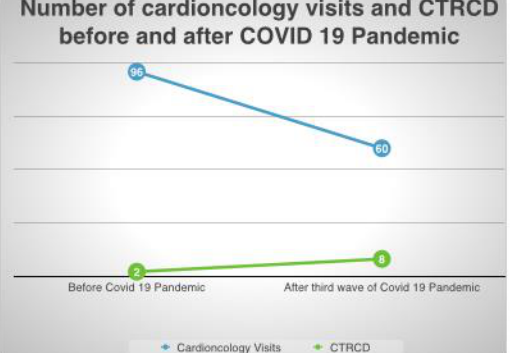
Figure 2. Graphical rapresentation of CTRCD and Cardio-Oncology visits before and after COVID-19 Pandemic.